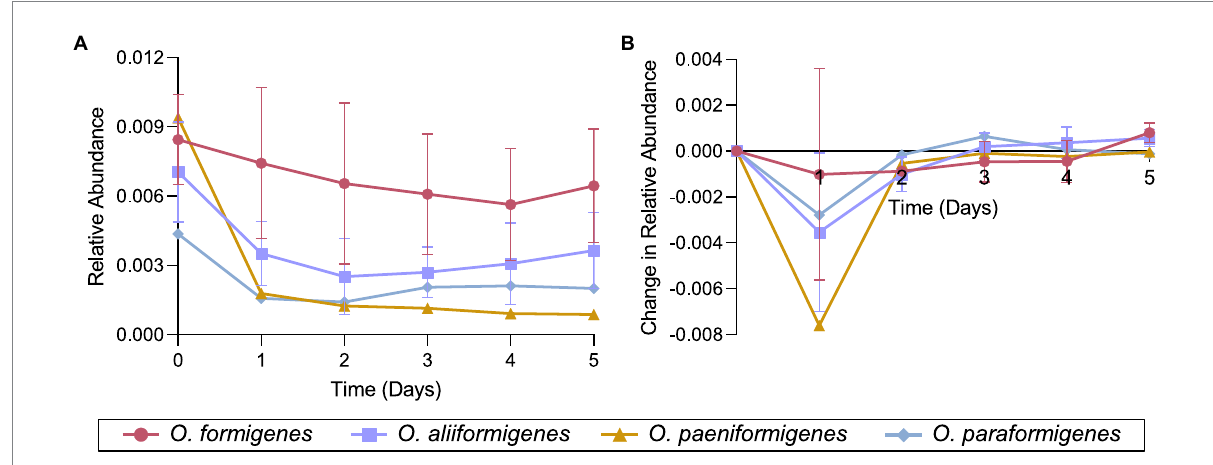
FIGURE 6 Species-specific growth of Oxalobacter in a simulated fecal environment. Oxalobacter species were individually inoculated into a simulated fecal environment and subsamples were taken every day for 5 days. (A) Relative abundance and (B) rate of change in relative abundance of each strain over time as detected by species-specific qPCR analysis. Data are displayed as mean ±